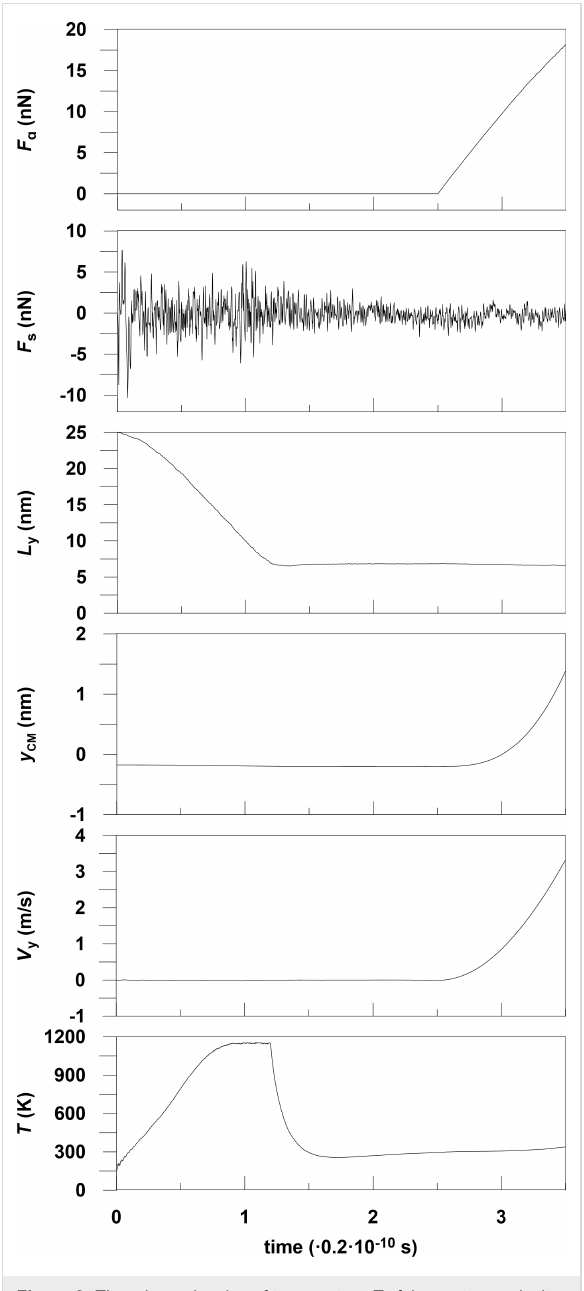
Figure 2: Time dependencies of temperature T of the system, velocity V y and lateral position y CM of the center of mass of the nanoparticle, lateral size L y , total substrate force F s , applied force F a calculated for Pd layer and nanoparticle containing 20000 atoms.